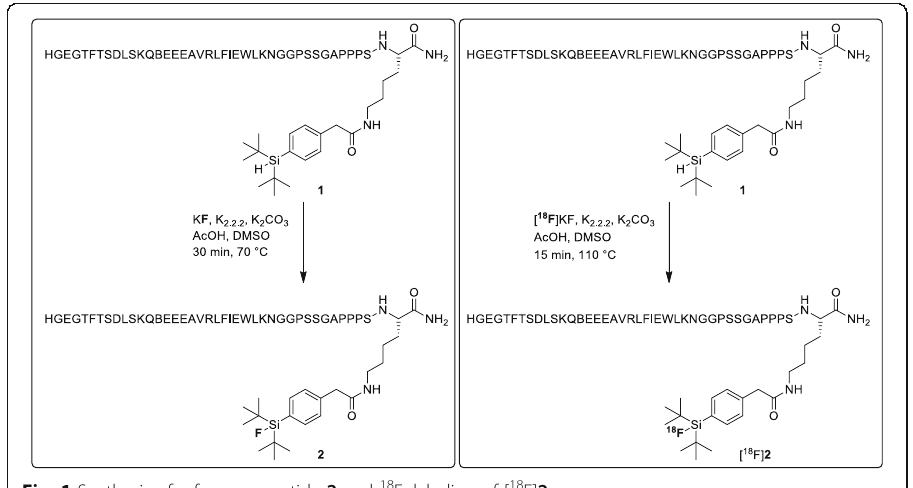
Fig. 1 Synthesis of reference peptide 2 and 18 F – labeling of [ 18 F]